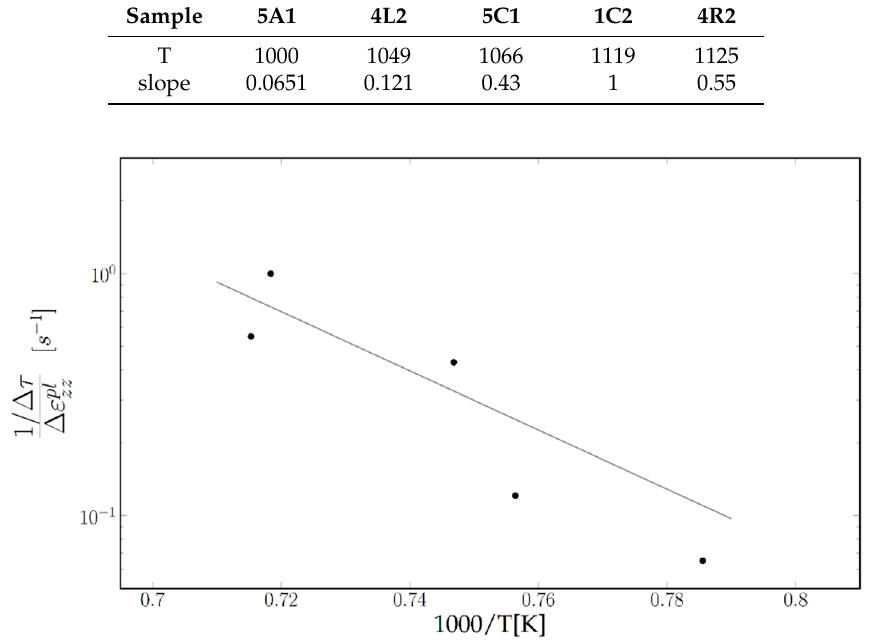
Table 2. Slope ∆ ( 1/ τ ) / ∆ ε pl zz for different “standard” specimens [28].